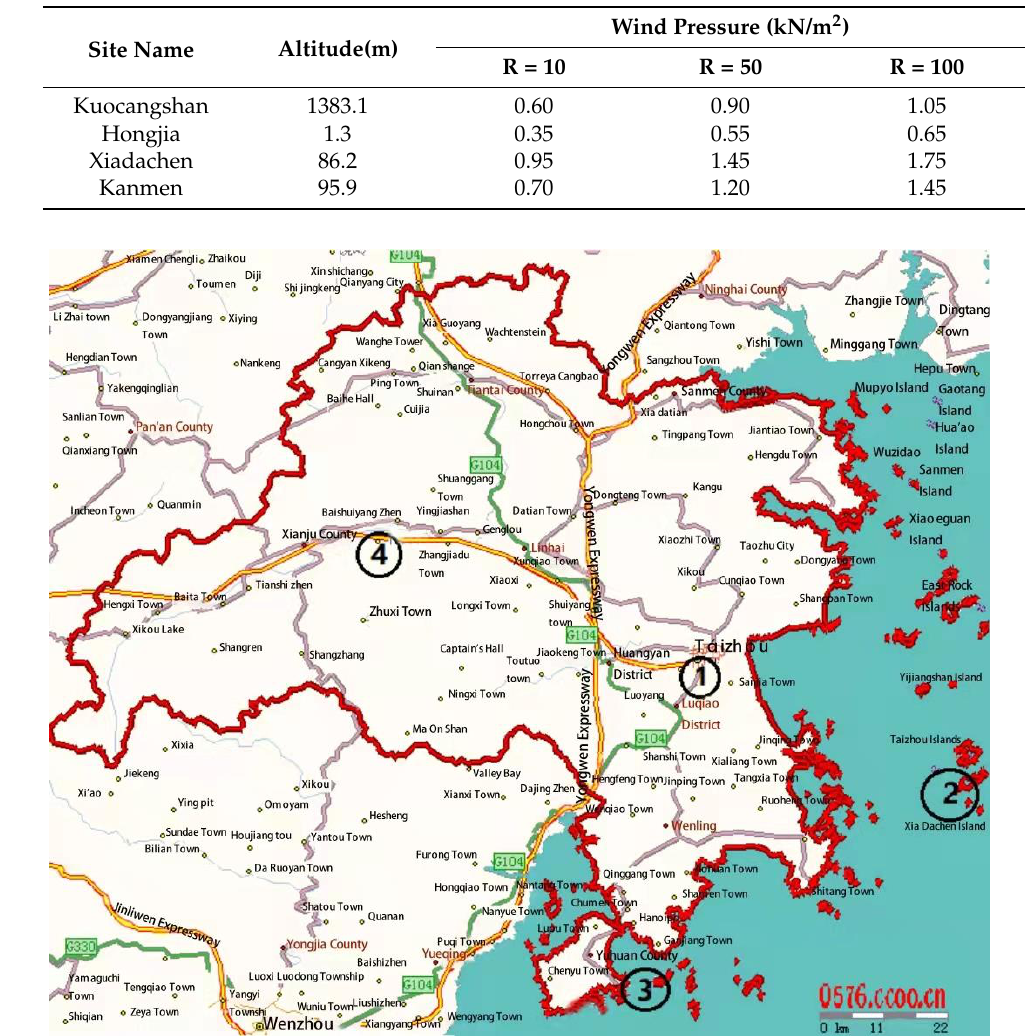
Table 1. The reference wind pressure in the Chinese load code (GB50009-2012) .